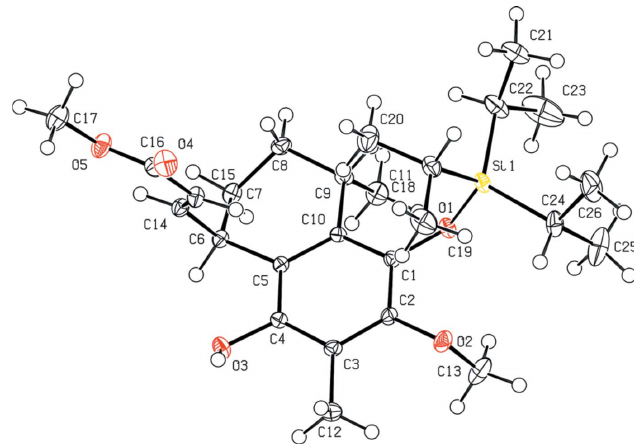
Figure 2 Molecular structure of ( 8 ) with displacement ellipsoids drawn at the 50% probability level.